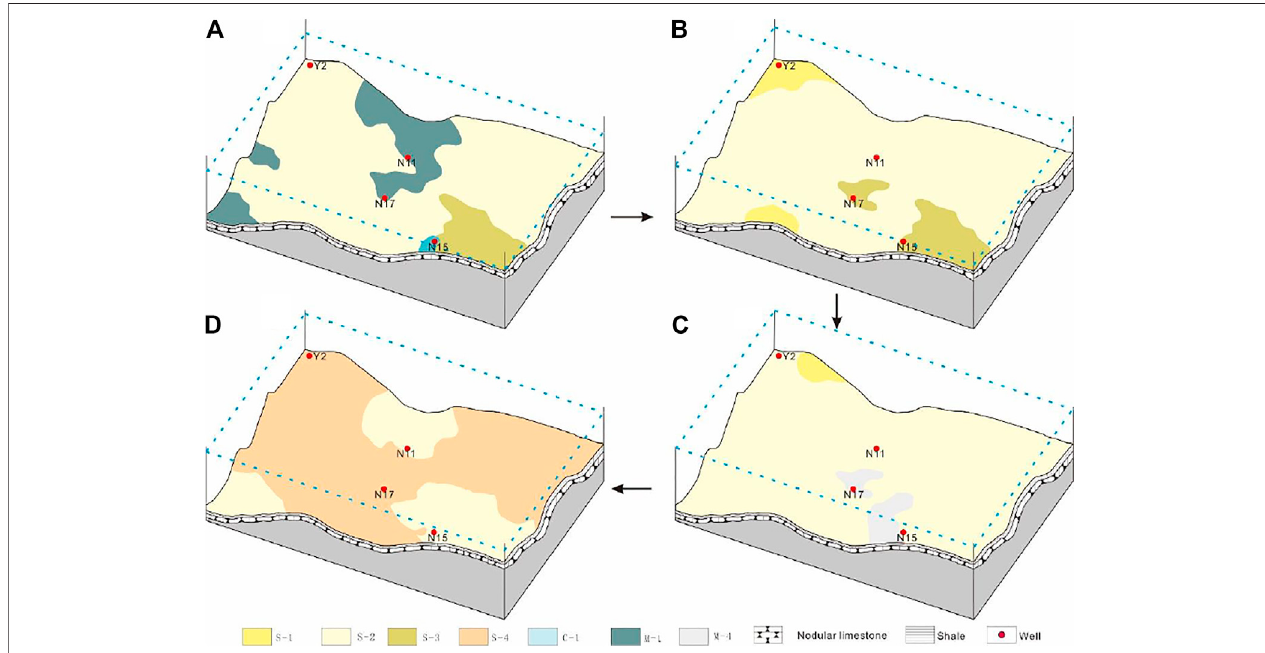
FIGURE 12 | Shale lithofacies evolution model of the Longmaxi Formation in the Changning area.